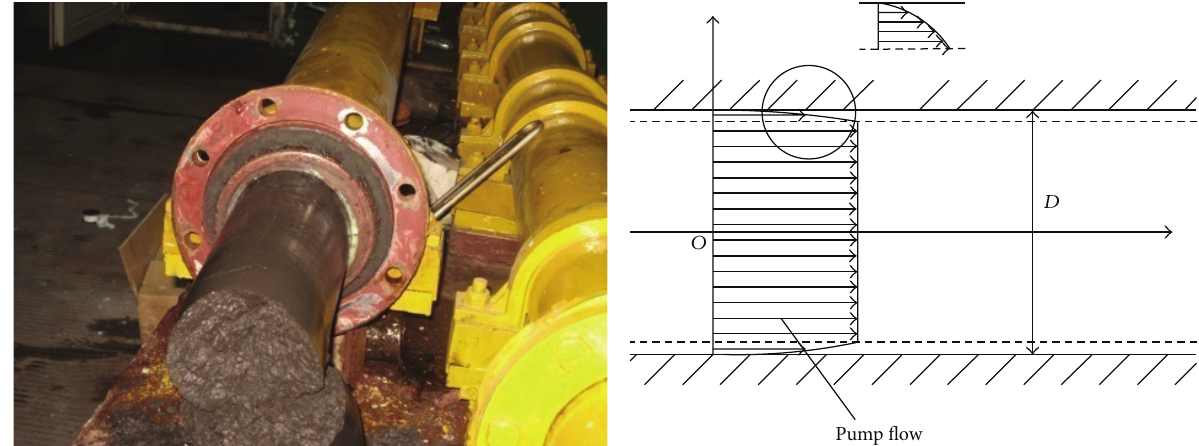
Figure 1: The appearance of the dense paste body in pipeline; and a thin water-rich layer forms between the paste body and inner pipe